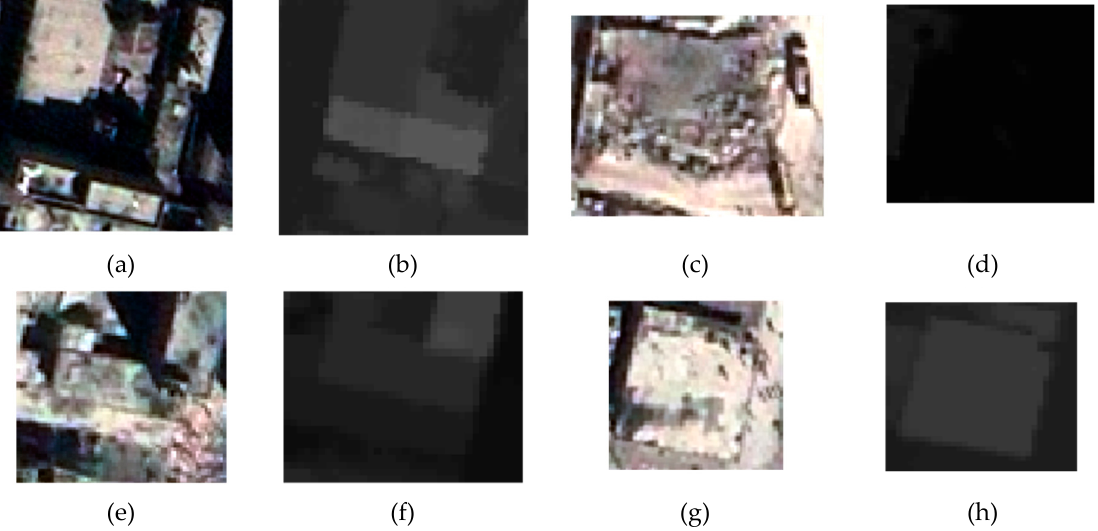
Figure 1. Samples of challenging buildings for damage assessment. Sub-images ( a , b ) show the effect of shadow in optical imagery and Lidar. In ( c , d ), damaged buildings are only detectable by the optical VHR dataset. In ( e , f ), the damaged building is only detectable via optical. In ( g , h ), the non-damaged building can be detected as such only in Lidar.